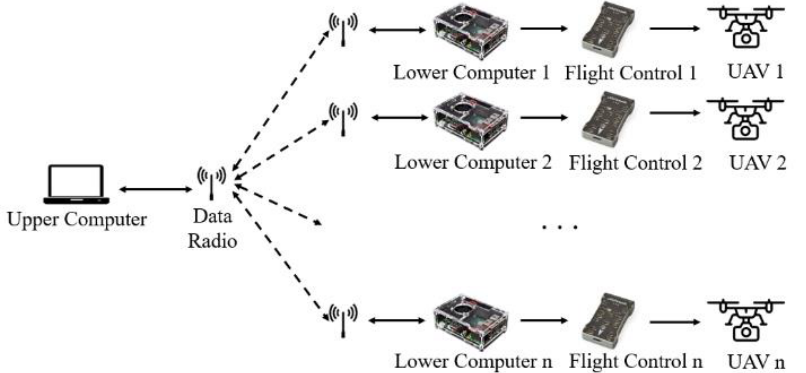
Figure 6. Formation control system.